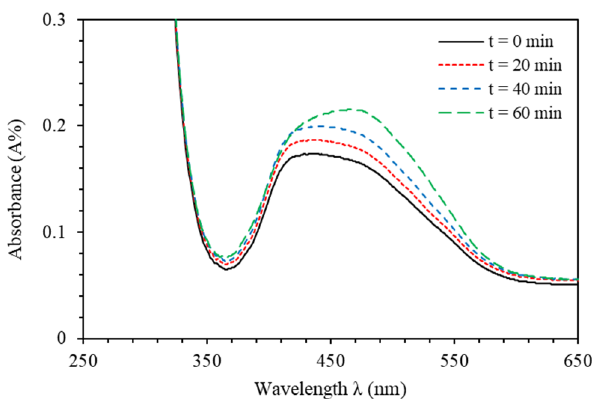
Figure 8. Absorbance spectra of PMMA-BDK-MR polymer composite thin film for various thermal process times: cis -case, cis / trans -transformation case (1) after 20 min, cis / trans -transformation case (2) after 40 min, and trans -state after 1 h.